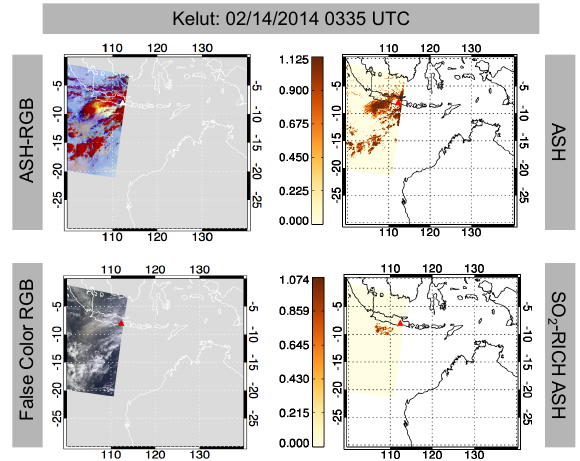
Figure 2. (Top left) Ash-RGB created using MODIS infrared bands 32–31, 31–29, and 31 for the eruption of Okmok, 12 July 2008, 2330Z; (bottom left) false color RGB created using MODIS reflec- tive bands 1, 4, and 3 for the same eruption and time; (top right) ash-detection neural network output for the same eruption and time; (bottom right) SO 2 -rich-ash-detection neural network output for the same eruption and time.